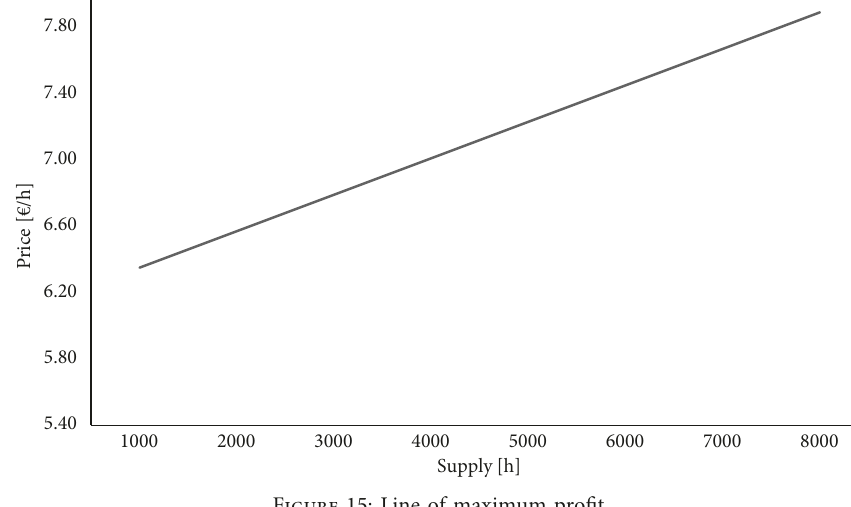
Figure 15: Line of maximum